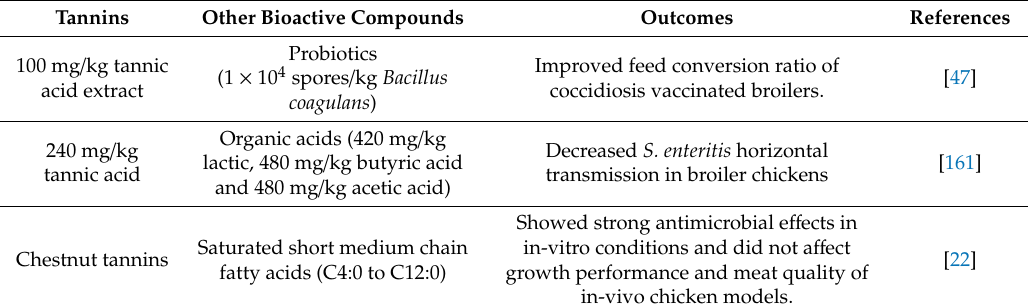
Table 3. E ff ects of tannins with other bioactive compounds on the chickens. Tannins Other Bioactive Compounds